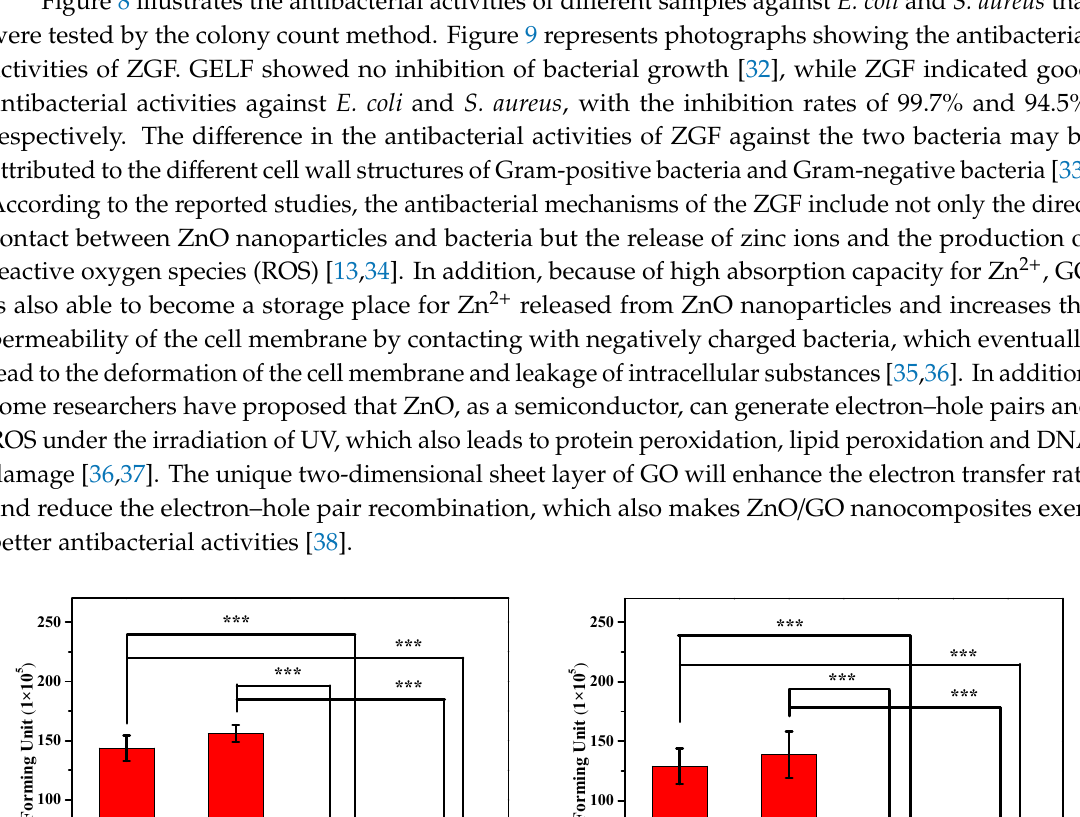
( h ) Figure 9. The photographs of antibacterial activities of negative control, GELF, ZGF and ZnO (positive control) to E. coli ( a – d ); to S. aureus ( e – h ). Figure 8 illustrates the antibacterial activities of different samples against E. coli and S. aureus that were tested by the colony count method. Figure 9 represents photographs showing the antibacterial activities of ZGF. GELF showed no inhibition of bacterial growth [32], while ZGF indicated good antibacterial activities against E. coli and S. aureus , with the inhibition rates of 99.7% and 94.5%, respectively. The difference in the antibacterial activities of ZGF against the two bacteria may be attributed to the different cell wall structures of Gram-positive bacteria and Gram-negative bacteria [33]. According to the reported studies, the antibacterial mechanisms of the ZGF include not only the direct contact between ZnO nanoparticles and bacteria but the release of zinc ions and the production of reactive oxygen species (ROS) [13,34]. In addition, because of high absorption capacity for Zn 2+ , GO is also able to become a storage place for Zn 2+ released from ZnO nanoparticles and increases the permeability of the cell membrane by contacting with negatively charged bacteria, which eventually lead to the deformation of the cell membrane and leakage of intracellular substances [35,36]. In addition, some researchers have proposed that ZnO, as a semiconductor, can generate electron–hole pairs and ROS under the irradiation of UV, which also leads to protein